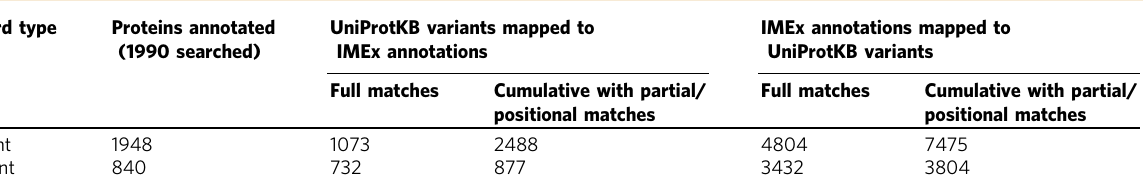
Table 4 Variant mapping summary